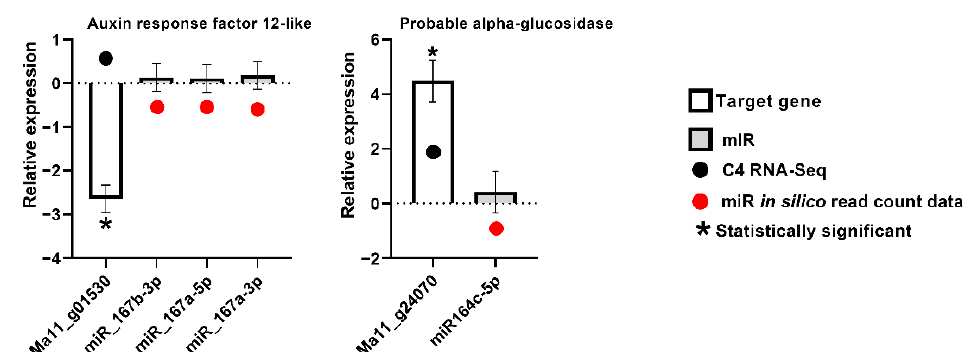
Figure 7. Stem-loop RT-qPCR and conventional RT-qPCR validation of differential expression profiles for selected miRNAs and their target genes in Musa acuminata var. Calcutta 4. Standard errors were calculated based on data for three biological replicates per treatment and three technical RT- qPCR ampli fi cation replicates.